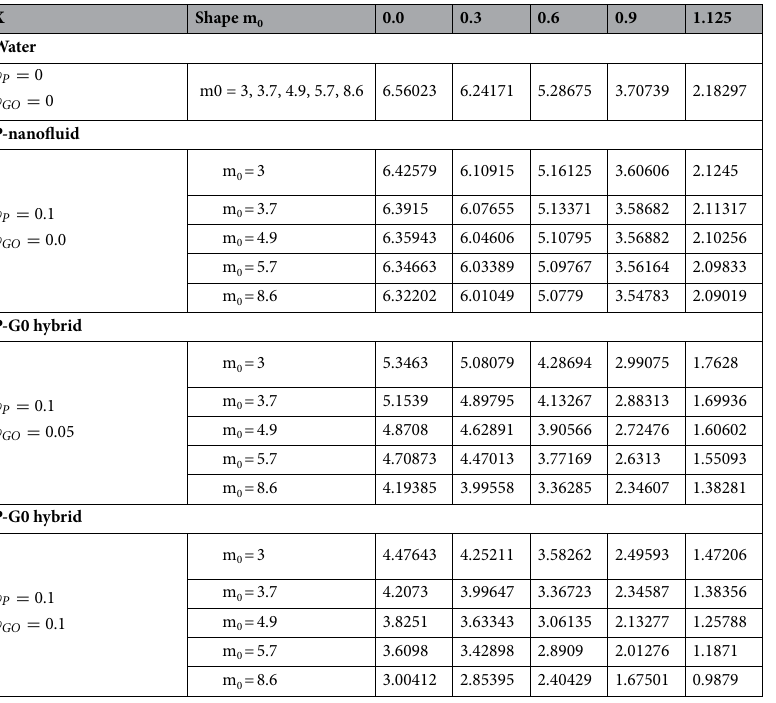
Table 3. Temperature field analysis for shape effect for P/water nanofluid, P-GO/water hybrid nanofluid and P-GO/water hybrid nanofluid keeping M = 10, m = 0.1, Q = 0.3, β = 0.2, γ = 0.3, ϕ = 0.1, B r = 0.4 for divergent